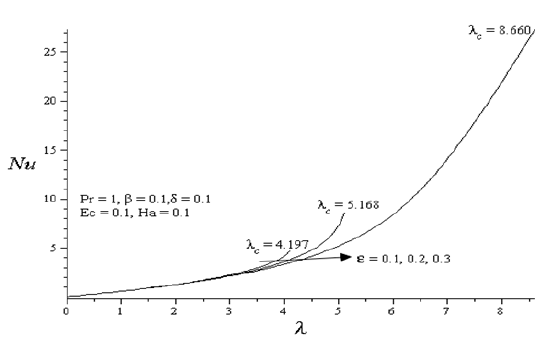
Figure 12. Nusselt number with increasing λ , δ , ( λ ity value).